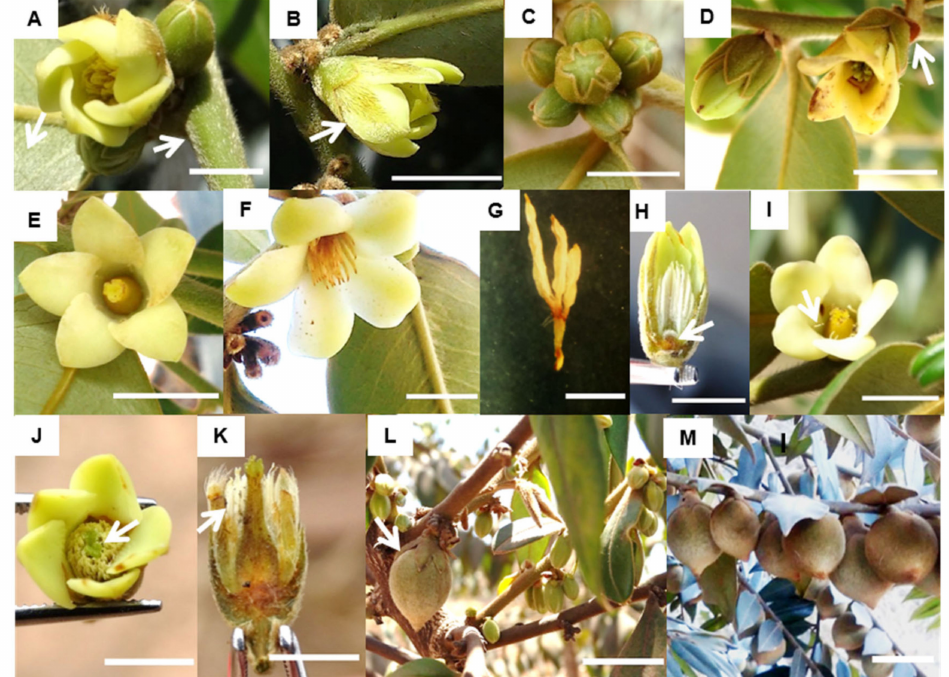
Figure 3. Floral biology traits of D. sericea located in the surroundings of the PESNT. ( A ) Sericeous aspect of the vegetative structures and ( B ) flowers, indicated by the arrow, bar = 1 cm; ( C ) multiple buds per axil in a male individual, bar = 1 cm; ( D ) solitary bud per axil in a female individual, and bracts indicated by the arrow, bar = 1 cm; ( E ) female flower with a bottle-shaped pistil, bar = 1 cm; ( F ) male flower, bar = 1 cm; ( G ) polyadelphous stamens fused at the base with free anthers, bar = 0.2 cm; ( H ) sericeous pistillode in a structurally male flower, bar = 0.5 cm; ( I ) staminodes in a structurally female flower indicated by the arrow, bar = 0.5 cm; ( J ) structurally male flower with a well-developed pistillode, with stigma indicated by the arrow, bar = 0.5 cm; ( K ) structurally female flower with well-developed staminodes indicated by the arrow, bar = 0.5 cm; ( L ) structurally male individual with a developed fruit at the branch base indicated by the arrow, bar = 3 cm; ( M ) structurally female individual with a fruit-bearing branch, bar = 3